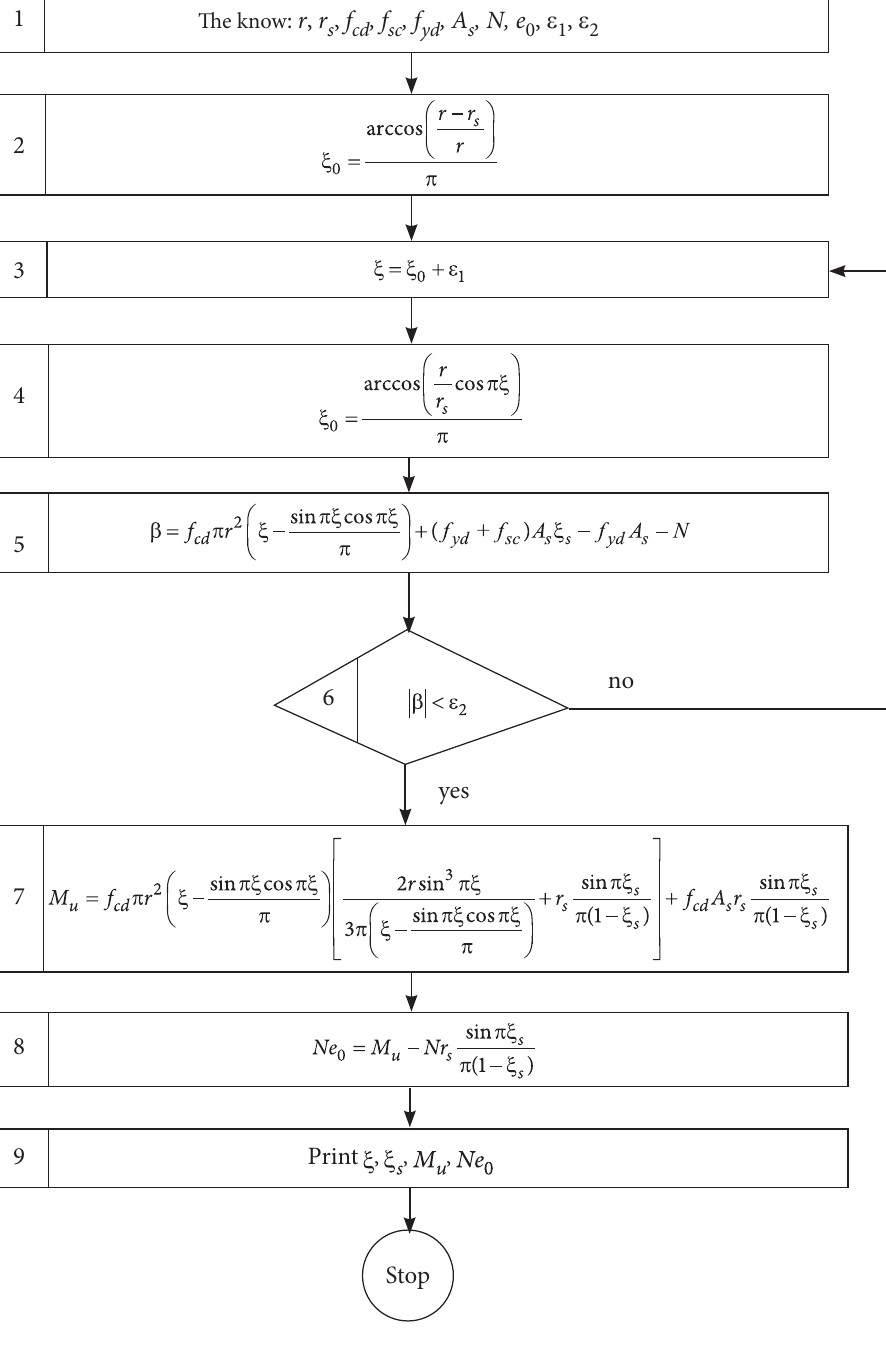
Fig. 4. The algorithm of evaluating the bearing capacity of the reinforced concrete elements of